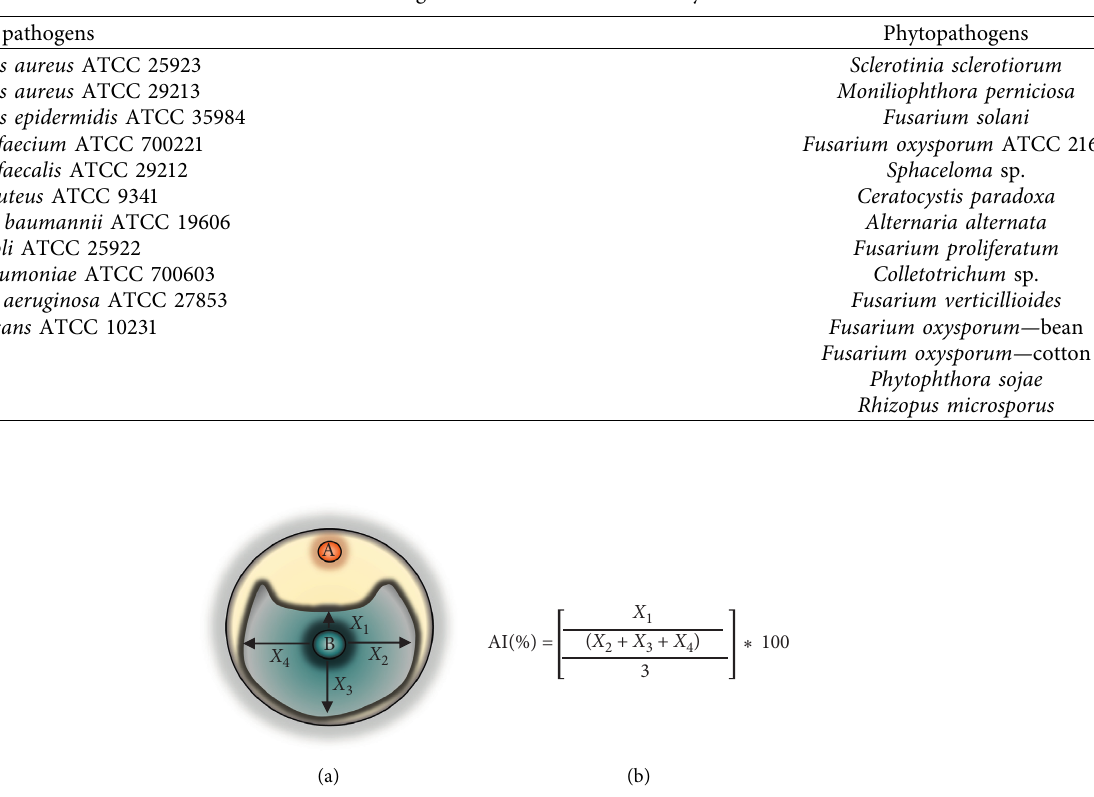
Figure 1: Schematic representation of the quantitative assay for the AI determination: (a) paper disk containing NPE of Burkholderia cepacia COPS; (b) phytopathogenic fungus mycelium. The inhibition index was calculated by the formula using the means of the mycelial growth measurements in